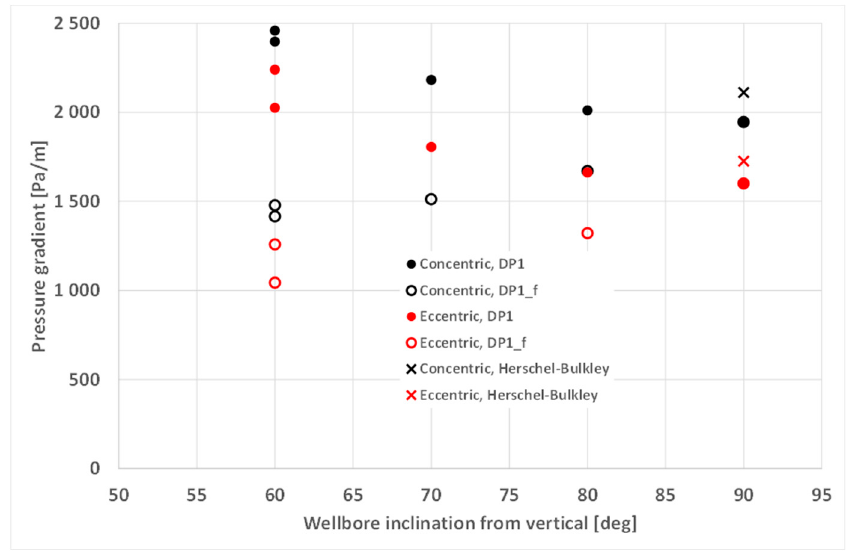
Figure 16. Measured pressure gradients DP1 for horizontal and inclined wellbore from experiments without inner pipe rotation, and corresponding frictional pressure gradients DP1_f, assuming a fluid density difference of 100 kg/m3. Crosses show corresponding calculations using the values from Table 5.